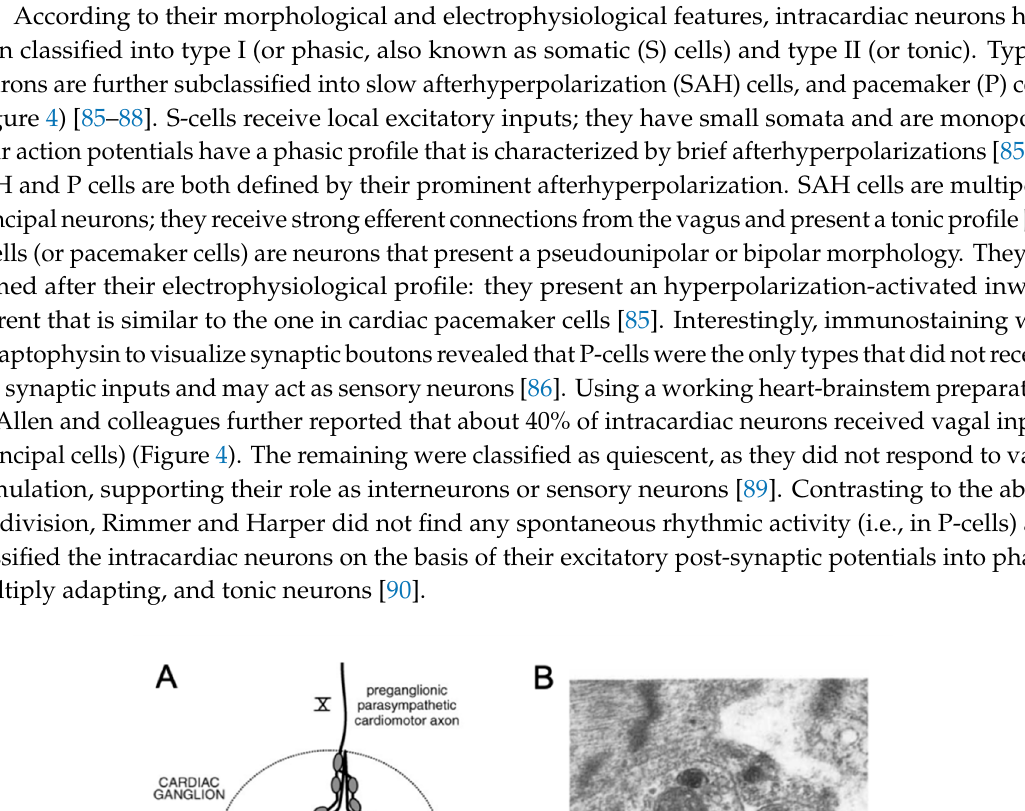
neurocardiac junction depicted in ( B ). Cholinergic vesicles are present in the prejunctional membrane facing the cardiomyocyte and the adrenergic varicosity, respectively whilst adrenergic vesicles